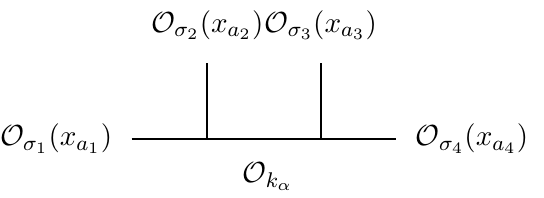
can be either external or internal operators. a (∆ ) for 1 ≤ a ≤ M together. We note a a